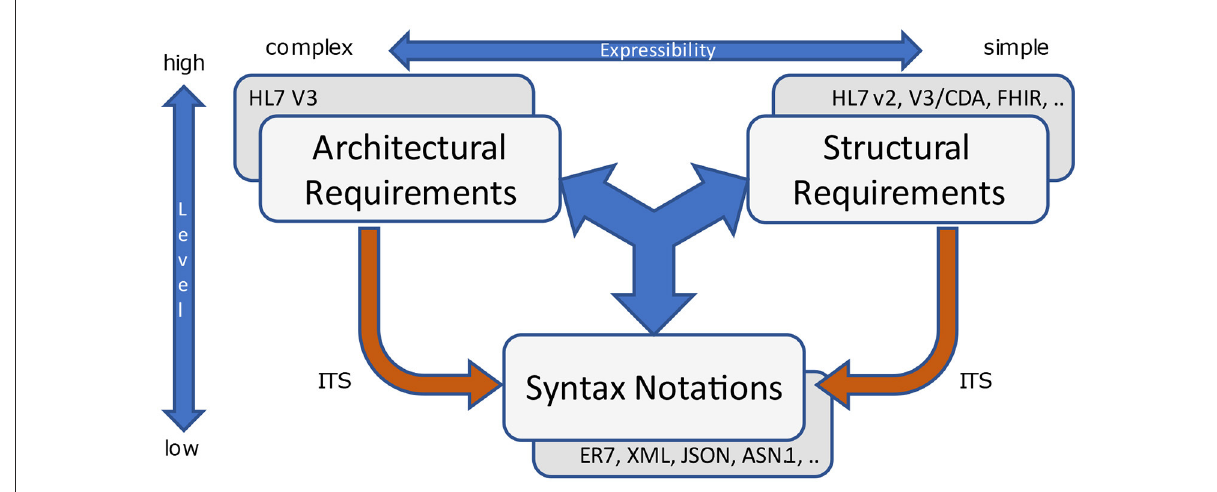
FIGURE13 Representation